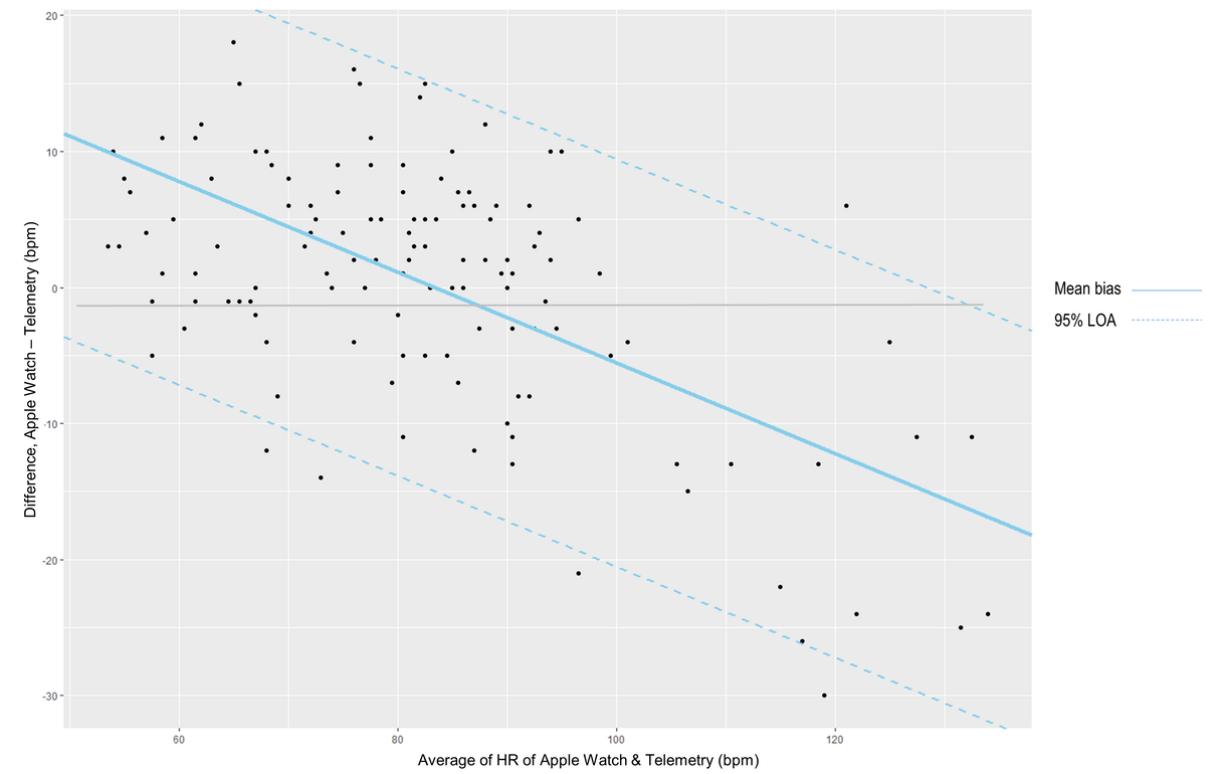
or thromboembolism, vascular disease (eg, peripheral artery disease, myocardial infarction, aortic plaque), age 65-74 years, sex category (ie, female sex). b CPAP: continuous positive airway pressure. Figure 3. Bland–Altman plot showing 95% confidence limits with progressive increase in